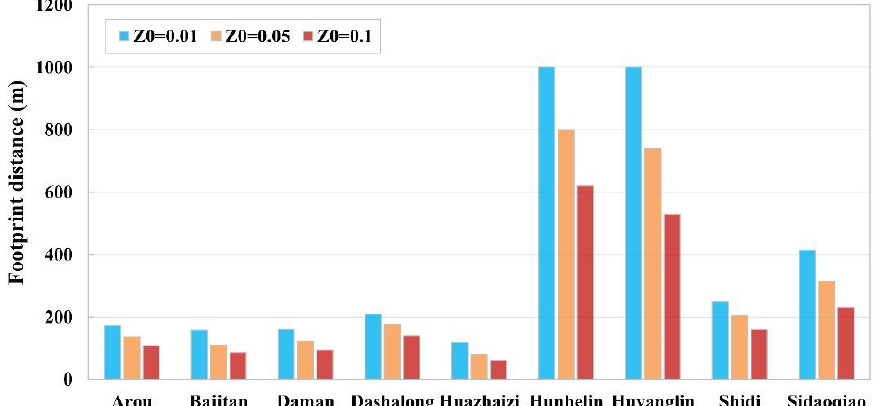
Figure 9. Changes in field GPP footprint with the changes in surface roughness.